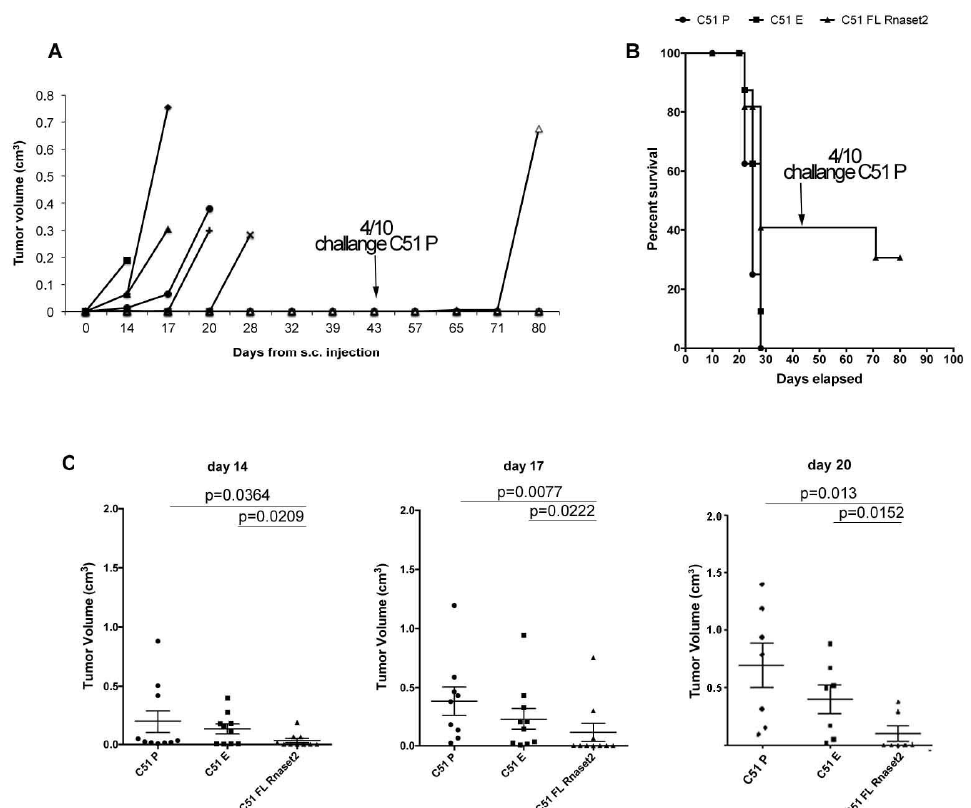
Figure 4. Tumor growth follow up of ten mice injected with C51 FL Rnaset2 up to about two months and subsequent follow up of tumor growth in four tumor-free of them receiving a C51 P tumor challenge until day 80 from the first C51 FL Rnaset2 injection (panel A ); survival curves versus time (days) of BALB / c mice groups injected with C51 P, C51 E, and C51 FL Rnaset2 cell lines (panel B ); in vivo analysis of tumor growth with statistical di ff erence at three time points (day 14, 17, and 20) of other groups ( N = ten animals in group) of BALB / c mice injected with C51 P, C51 E, and C51 FL Rnaset2 cell lines (panel C ). Horizontal bars indicate mean ± SE (Standard error) values for each group. p values of statistically significant di ff erences between the groups connected by lines are also reported. An ANOVA statistical analysis was performed assuming p <